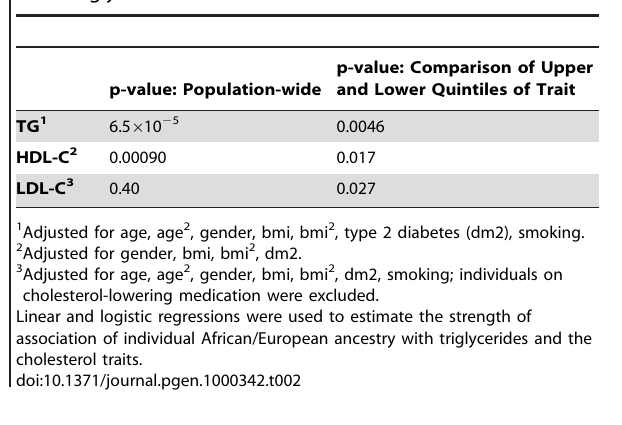
Table 2. Individual African-European Ancestry is associated with Triglyceride and Cholesterol